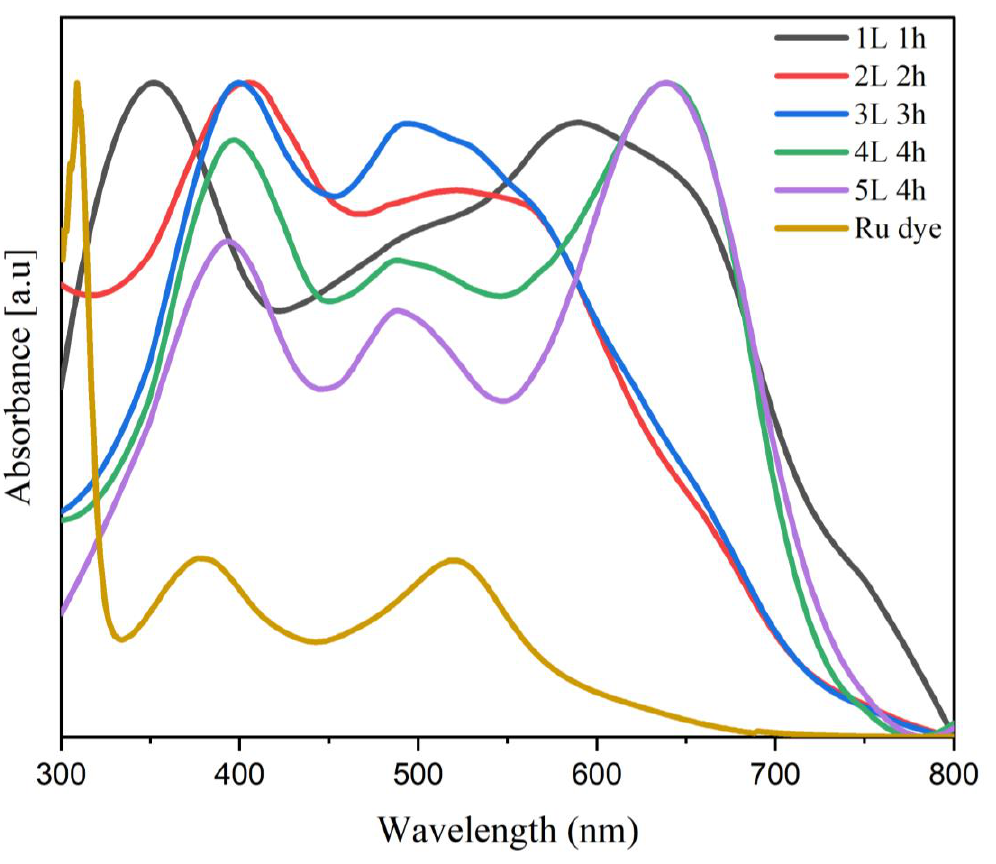
Figure 8. The absorbance spectrum of ZnO film with different layer thicknesses soaked in dye for different soaking times.